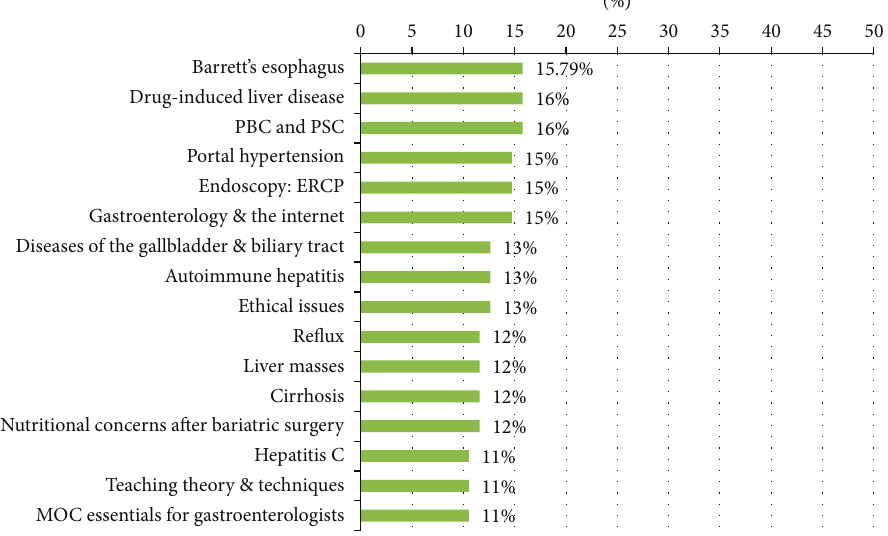
Figure 3: Educational topics in which 11–16% of respondents were “very interested.” PBC: primary biliary cirrhosis; PSC: primary sclerosing cholangitis; ERCP: endoscopic retrograde cholangiopancreatography; MOC: maintenance of certification.